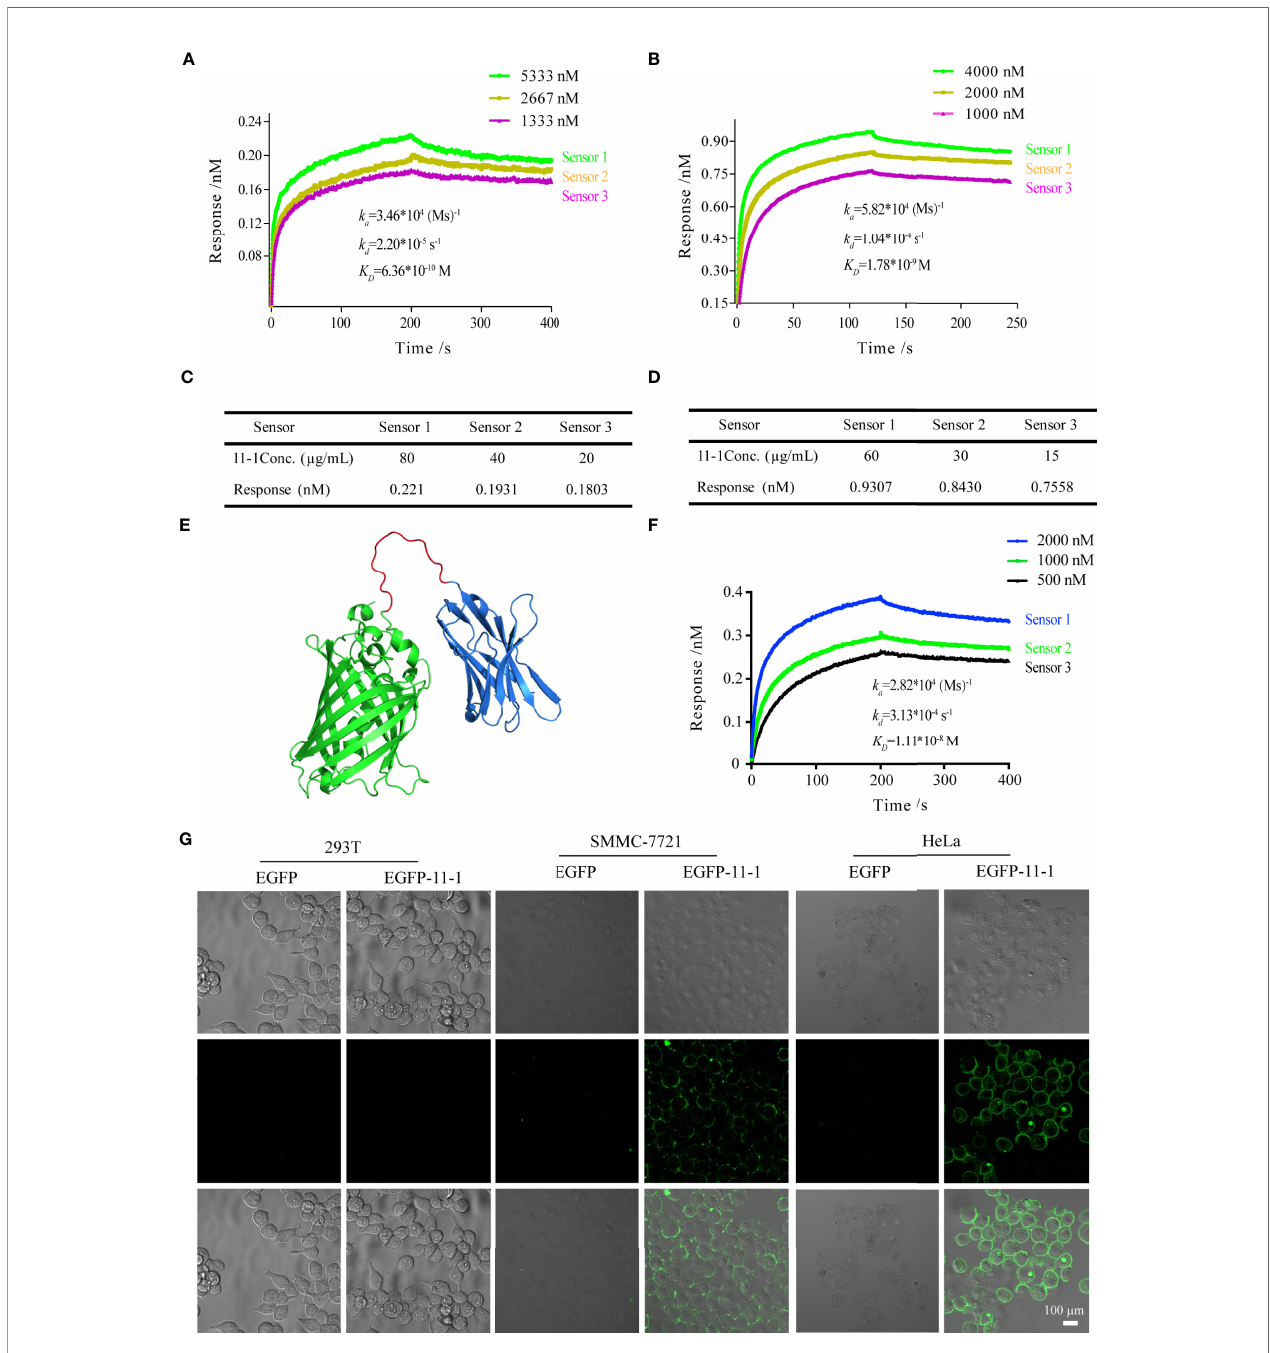
FIGURE 3 | Thetumor-targetingeffectsofanti-CD147nanobody invitro assays. (A) Theinteractionofkineticsbetween11-1 andCD147. (B) Theinteractionofkineticsbetween 11-1 andC78. (C) Theresponse ofCD147correctedwith11-1 concentration. (D) TheresponseofC78correctedwith11-1 concentration. (E) Thepredictedspatialstructureof EGFP-11-1. (F) Theinteractionofkinetics betweenCD147 andEGFP-11-1. (G) Cell fl uorescence analysisassay.Thecelllines involved293T, SMMC-7721, andHeLa;EGFP-11- 1(2mg/ml,20 m l)andEGFP(2 mg/ml, 20 m l) wereincubatedwiththesecells at4°C for 15min,andthesecellswerewashedthreetimeswithPBS. 293TcellsandEGFPprotein wereusedasnegative controls.Scalebar =100 m